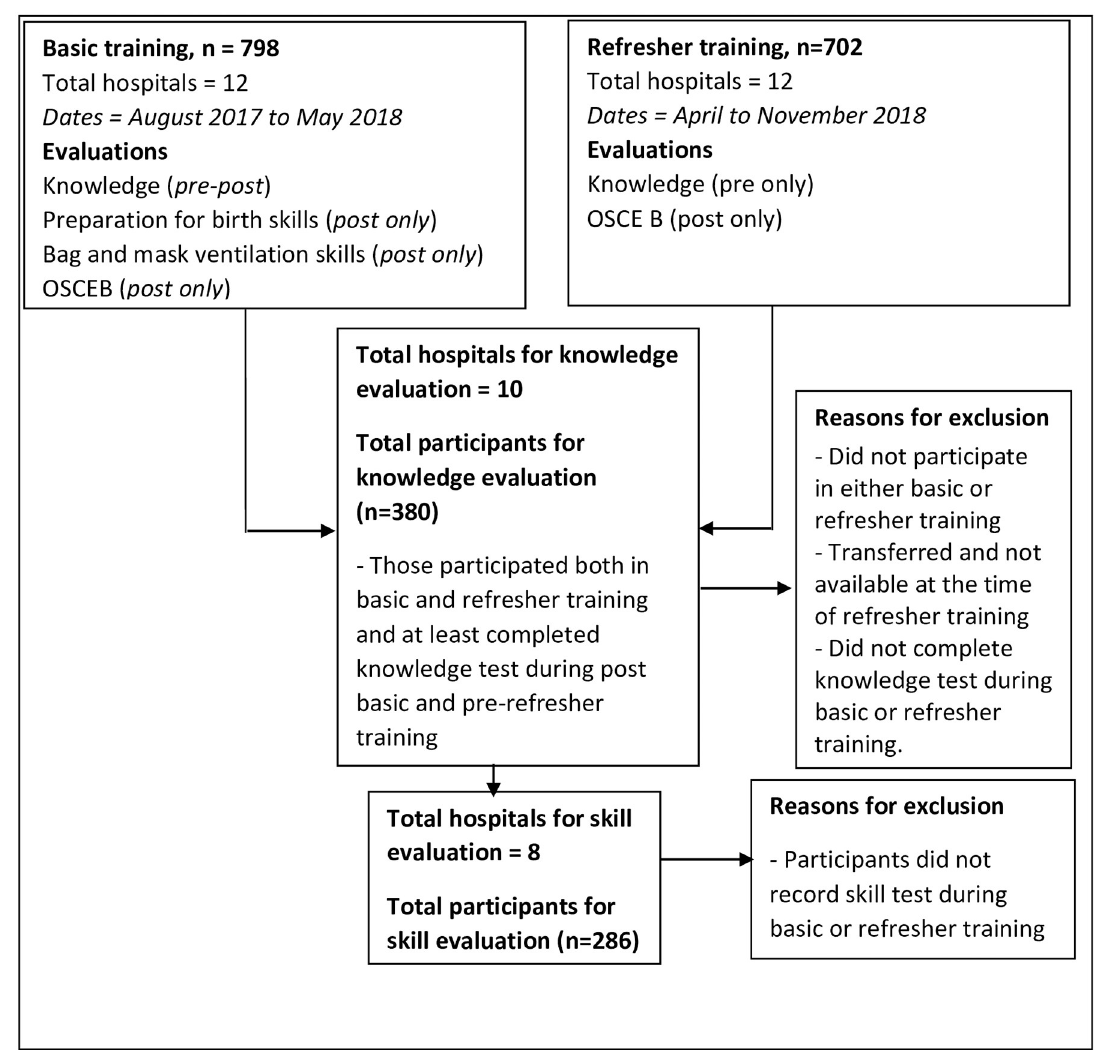
Fig 1. Flow diagram of training